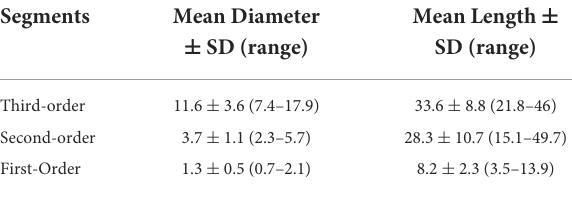
TABLE 1 Average diameters (mm) and lengths (mm) of the first-, second-, and third-order venous